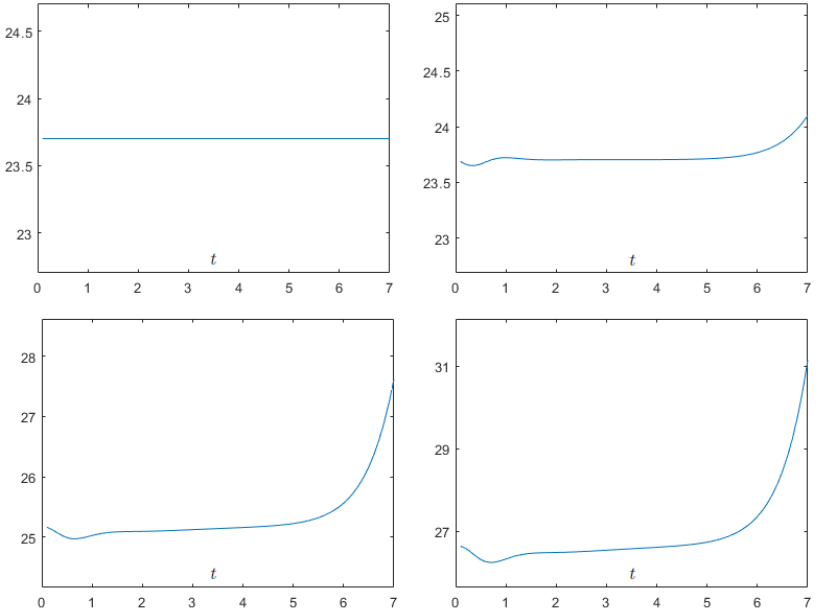
(cid:107) 2 computed by the numerical t